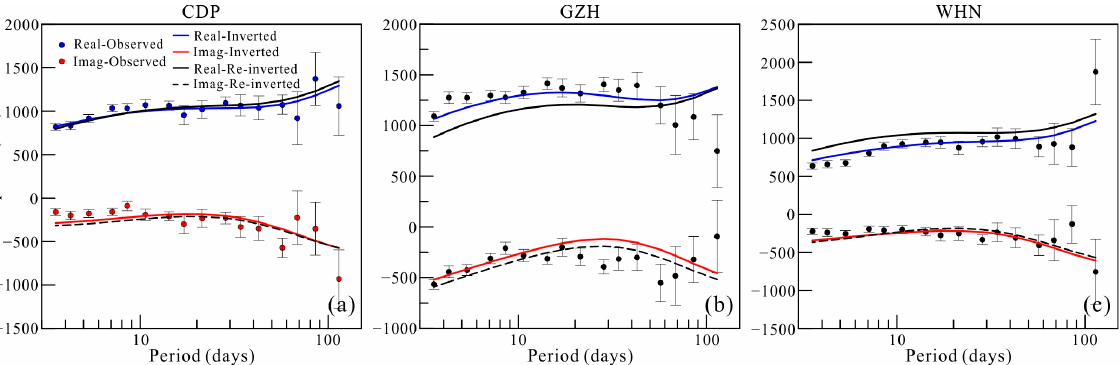
Figure 10. Fitness curves of the response of inversion results, re-inverted results, and the observed C-responses for three geomagnetic observatories (CDP ( a ), GZH ( b ), and WHN ( c )) distributed around Anomaly A.